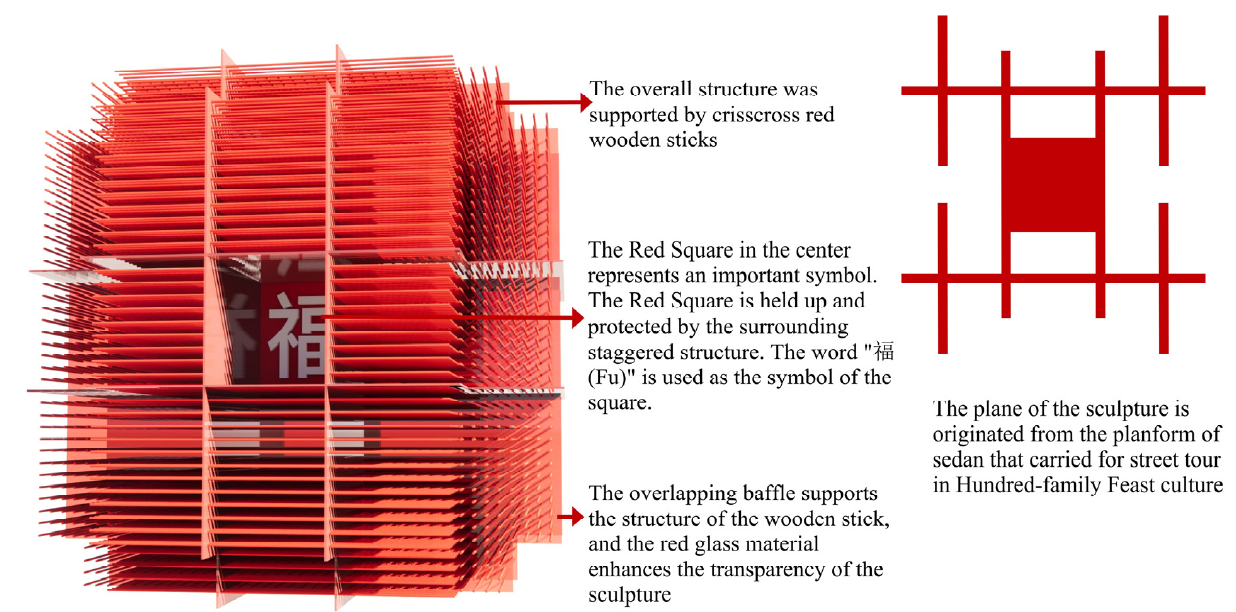
Figure 19. Fufang Figure 19. Fufang sculpture.